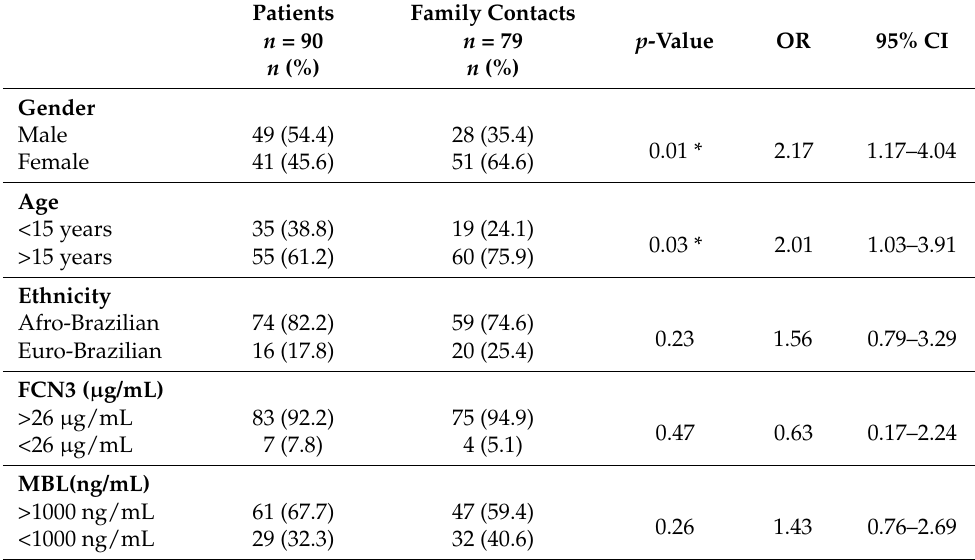
Table 1. Distribution of sociodemographic characteristics and serum concentrations of FCN3 and MBL in leprosy patients and healthy family